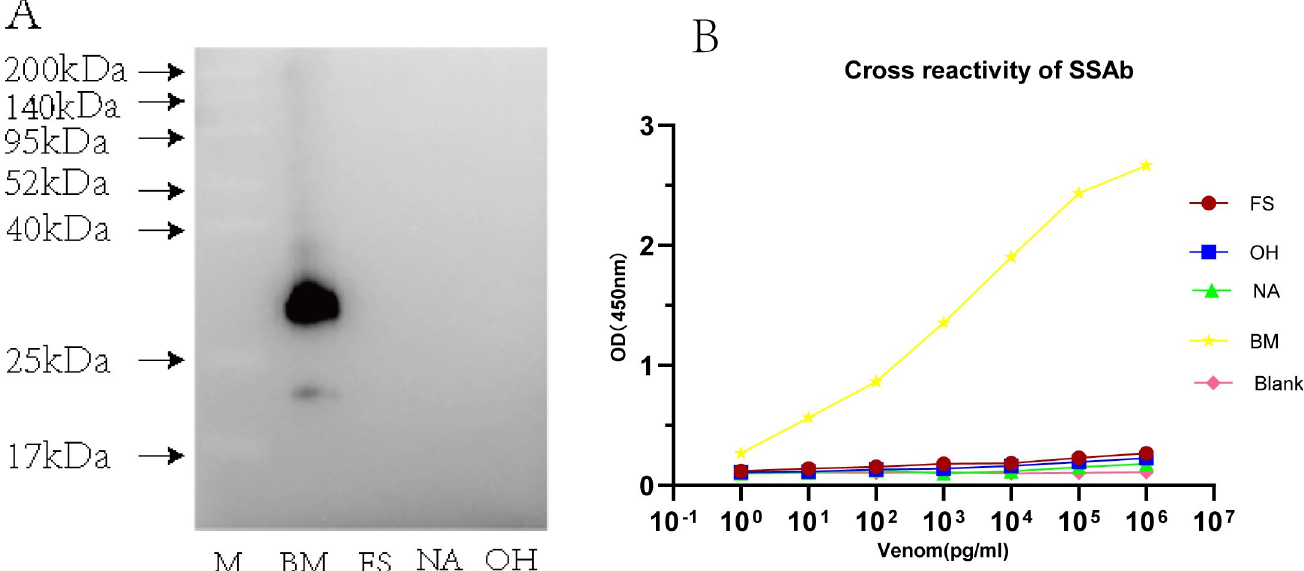
Fig 6. Specificity assessment of SSAb by Western blot and sandwich ELISA. (A) The venoms of BM, FS, NA, and OH were transferred to the PVDF membrane and hybridized by SSAb screened from commercial BM antivenin. The arrows represent the MW in kilodalton (kDa). (B) The rabbit APAb (2 μ g/ml) as the capture antibody was incubated with BM venom (range of 0.001–1000 ng/ml). BSA was used as a blank. The OD values (n = 3) are presented herein as mean ±